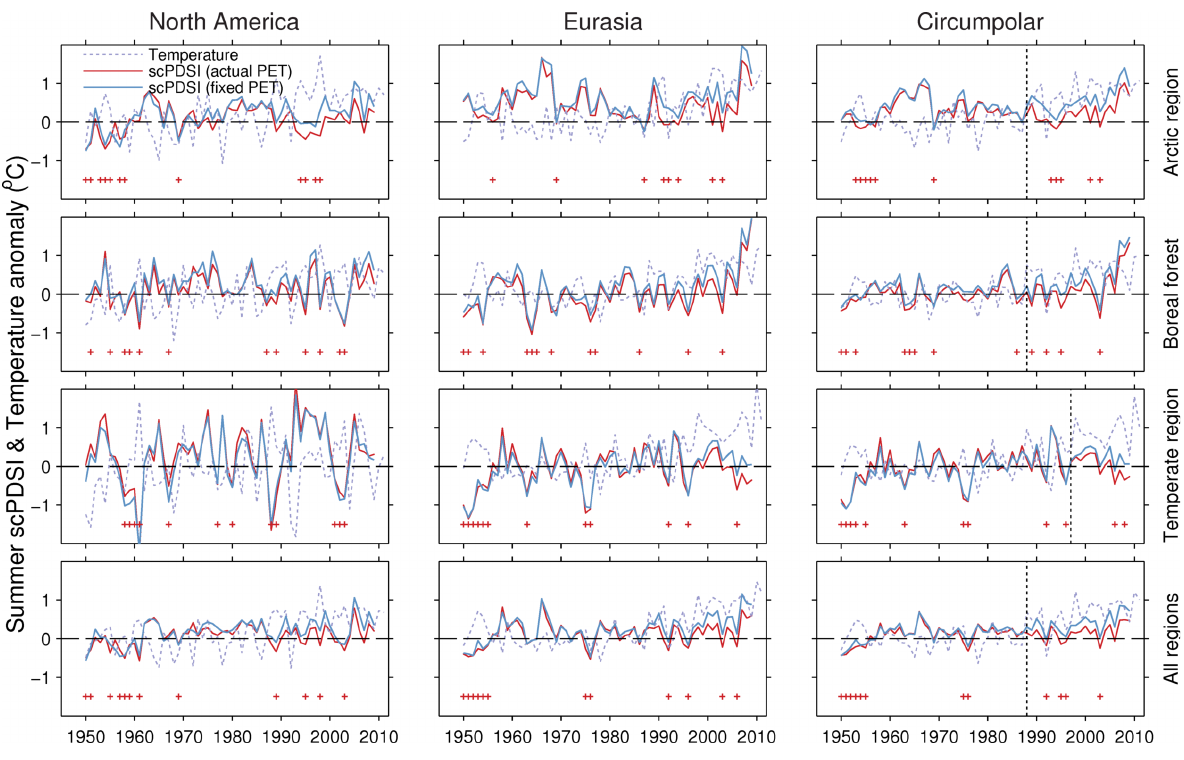
Figure 2. Comparison by region and continent between summer scPDSI averages with (red) and without (blue) interannual changes in potential evapotranspiration (PET). Mean summer temperature anomalies relative to the period 1961–1990 (dotted line) are shown for each biome. The red crosses in each panel indicate values of the average scPDSI series with actual PET within the bottom 20th percentile, which can be thought as regional summer droughts. Note that the severity of most of these drought events occurring during the warming period over the last two decades has been intensified by increasing evapotranspiration demand. The vertical dotted lines denote the years 1988 or